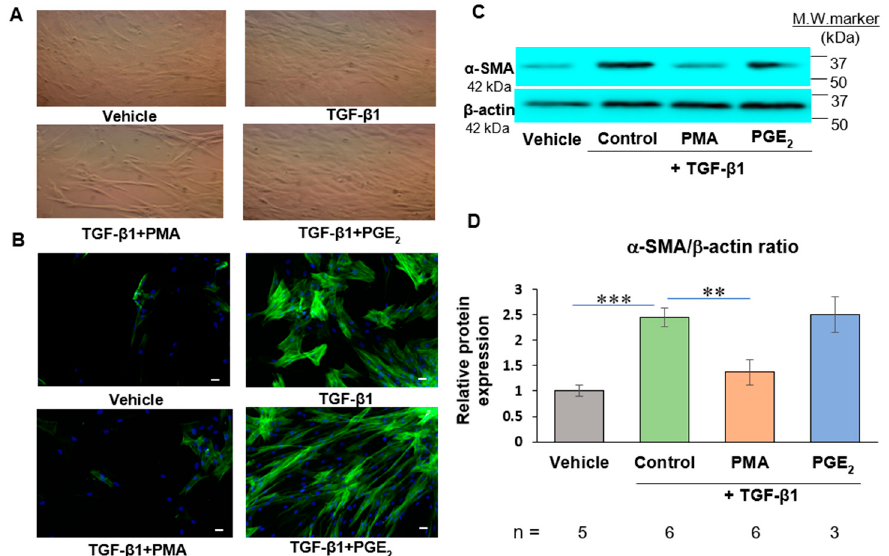
Figure 2. PMA but not PGE 2 dedifferentiates de novo human cardiac myofibroblasts induced by TGF- β 1 from human cardiac fibroblasts (HCFs). ( A ). Phase-contract images of HCFs or human cardiac myofibroblasts treated with PMA or PGE 2 were shown. Magnification: 100 × . ( B ). Double immunostaining of α -SMA (green) and DAPI (blue) in HCFs or human cardiac myofibroblasts was performed. Increased expression of α -SMA was demonstrated in cardiac myofibroblasts after exposure to TGF- β 1 at 2 ng/mL for 48 h. PMA at 50 ng/mL reduced expression of α -SMA. PGE 2 at 500 nM did not affect the increased α -SMA expression in cardiac myofibroblasts. Scale bar = 20 µ m. ( C ). Representative images of protein expression of α -SMA in cardiac myofibroblasts were shown. Beta-actin was used as a loading control. ( D ). Immunoblot analysis showed increased protein levels in cardiac myofibroblasts treated with TGF- β 1. PMA reduced expression of α -SMA. PGE 2 did not affect increased α -SMA expression in cardiac myofibroblasts. n: independent samples per group. Bar: mean ± SEM. ** p < 0.01, *** p < 0.001.